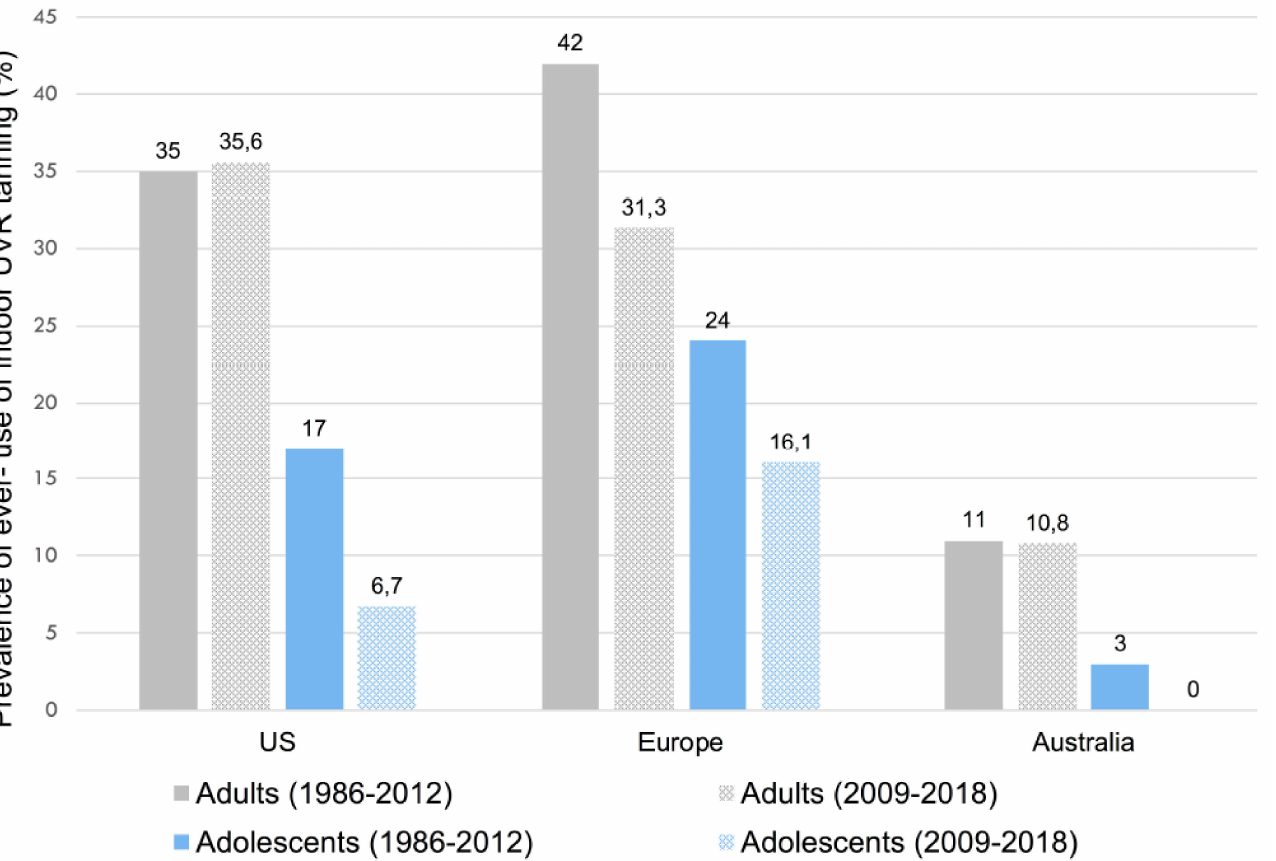
Figure 1. Summary prevalence estimates (%) reported in published meta-analyses on the ever-use of indoor UVR tanning. (The prevalence for the years 1986–2012 is reported in Wehner et al. [12], and for the years 2009–2018 in Rodriguez-Acevedo et al.